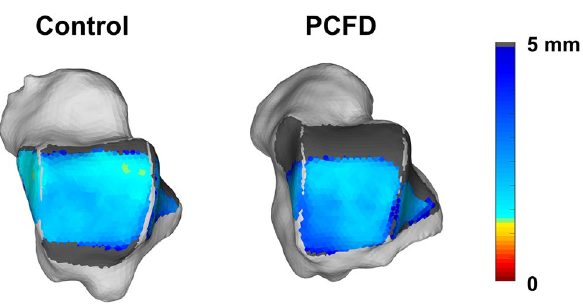
Figure 3. Superior view of the talus showing distance maps of the tibiotalar joint for a control and a Progressive Collapsing Foot Deformity (PCFD) patient. Dark grey regions identify areas that were not covered by the tibia (articular uncoverage).